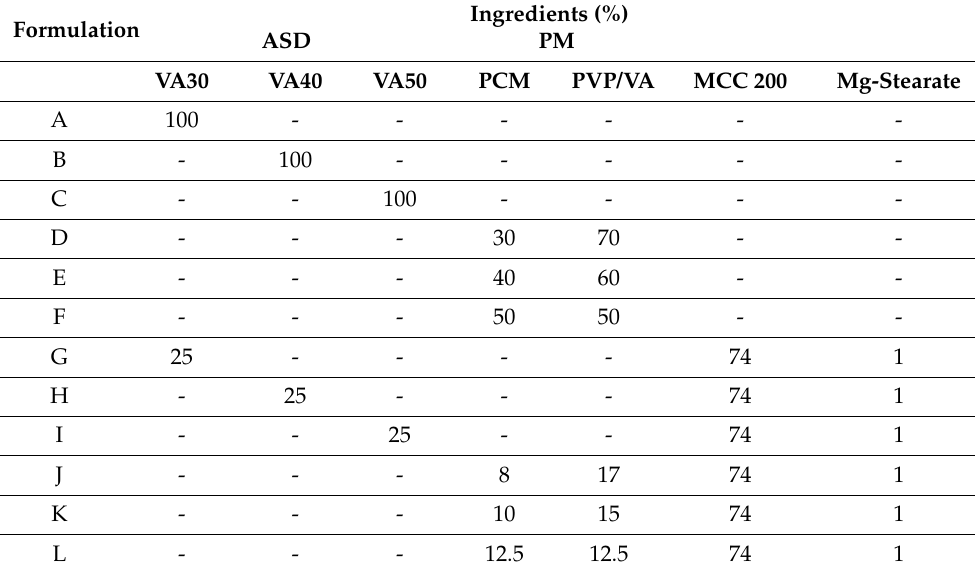
Table 2. Composition of tablets. Example: formulation K is physical mixture (PM) tablet. It